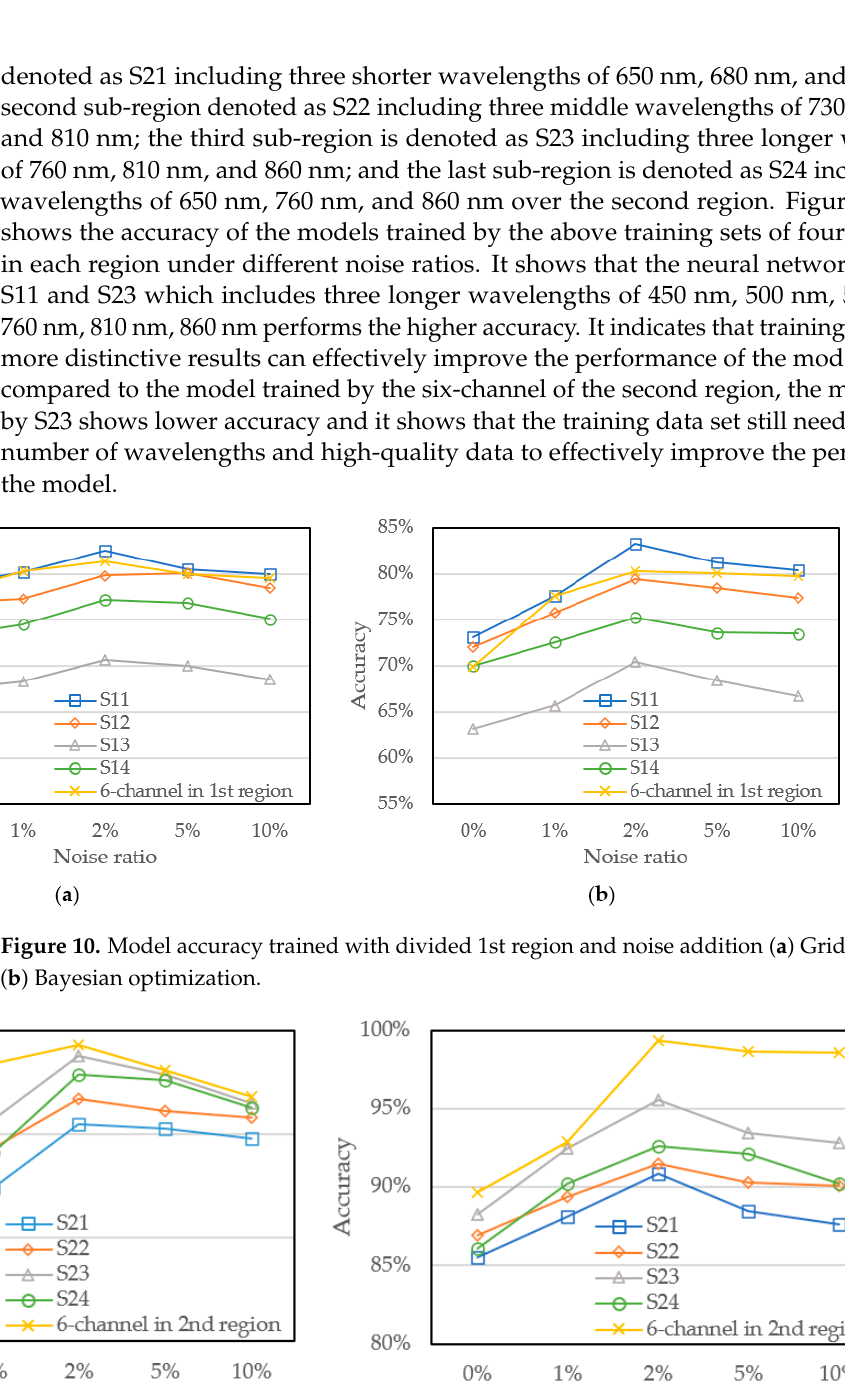
Figure 11. Model accuracy trained with divided second region and noise addition ( a ) GridsearchCV and ( b ) Bayesian optimization.